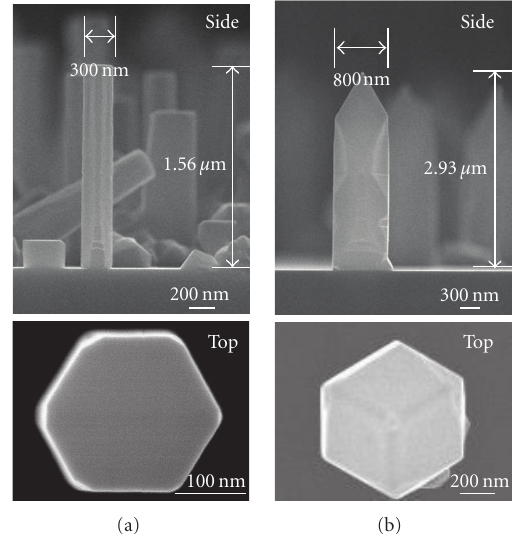
Figure 8: SEM images of GaAs/GaP nanopillers on Si. Diameters of Au colloids are (a) 5 and (b)